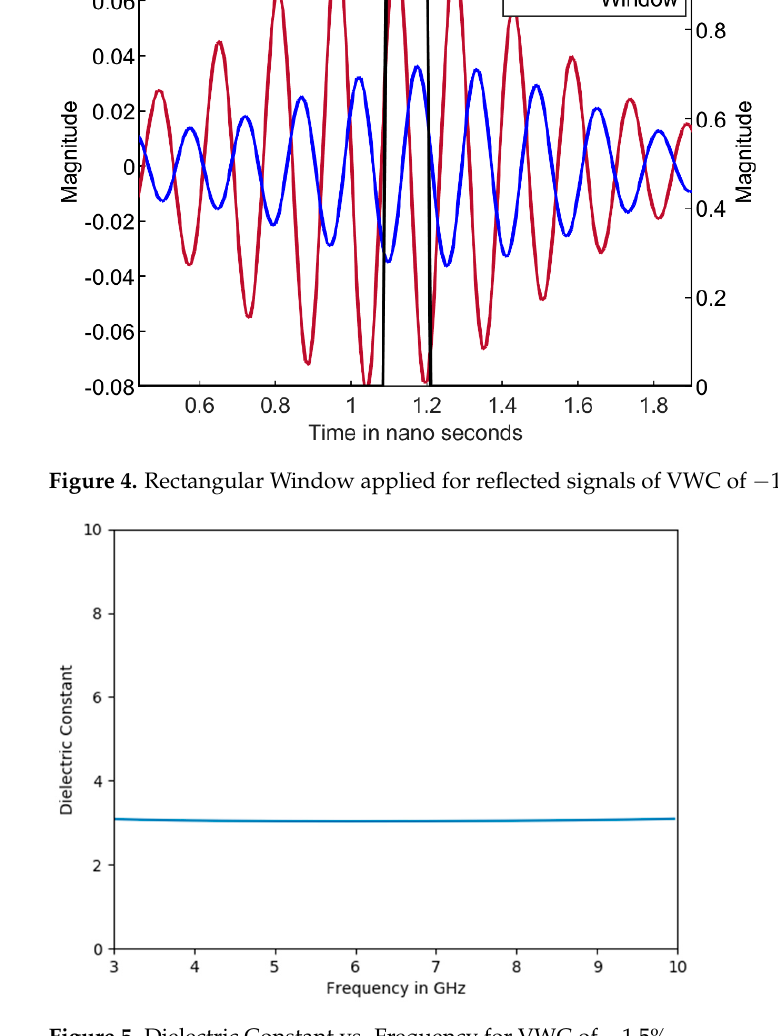
Figure 5. Dielectric Constant vs. Frequency for VWC of − 1.5%.